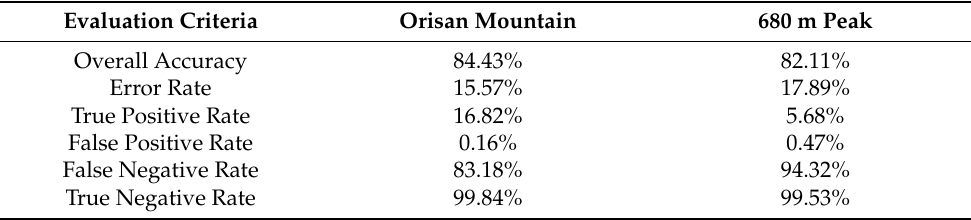
Table 2. Comparison of evaluation criteria between the Orisan Mountain and 680 m peak eruptions compared with the ground truth data (of the HRVF).